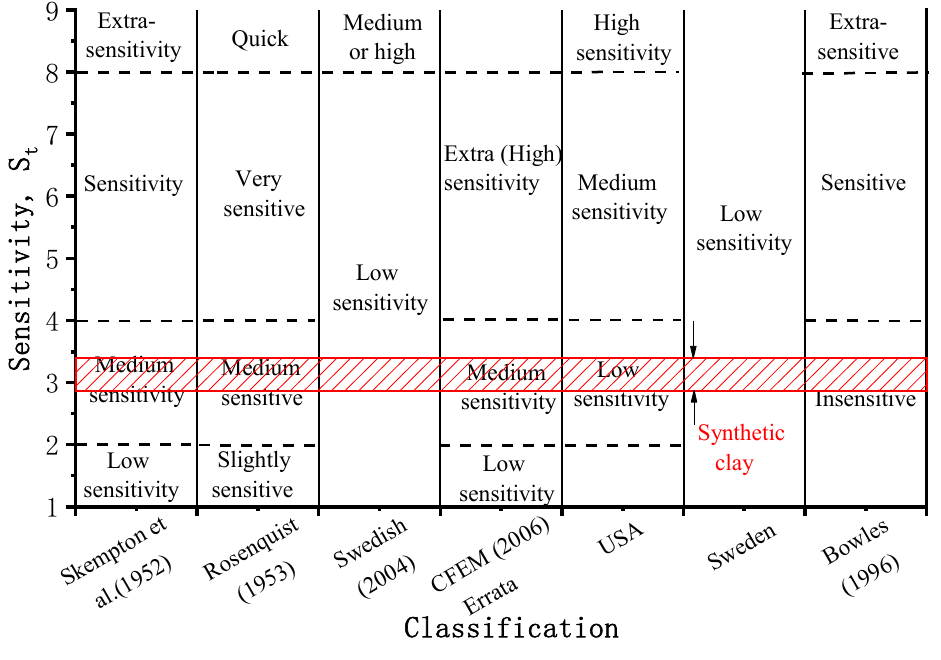
Figure 11. Classification of sensitivity.